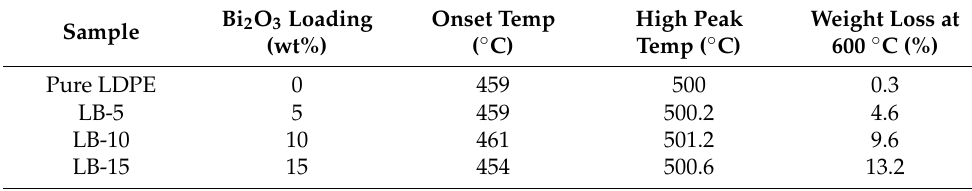
Figure 1. TGA thermograms for pure LDPE and LDPE/ Bi 2 O 3 composites. Table 2. Summary of the TGA thermograms for pure LDPE and LDPE + Bi 2 O 3 composites.